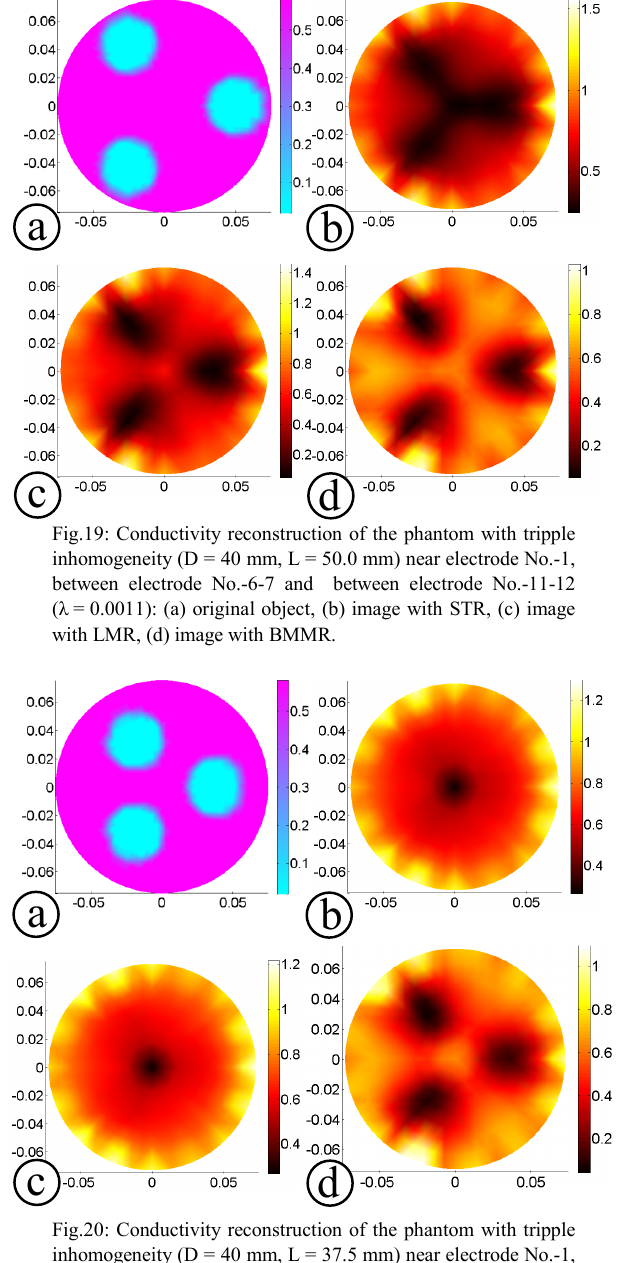
Fig. 20: Conductivity reconstruction of the phantom with tripple inhomogeneity (D = 40 mm, L = 37.5 mm) near electrode No.-1, between electrode No.-6-7 and between electrode No.-11-12 ( λ = 0.0011): (a) original object, (b) image with STR, (c) image with LMR, (d) image with BMMR A reconstruction study (with λ = 0.00011) shows that, for the phantom with three objects (D = 40 mm, L = 37.5 mm)